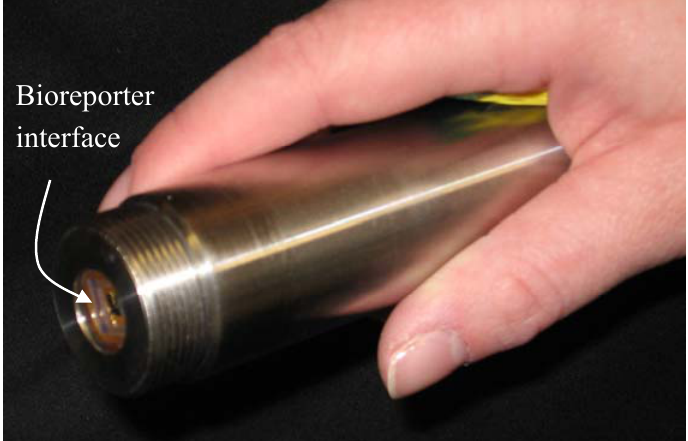
Figure 2. Example of a CMOS microluminometer transducer in a hand-held biosensor format. Bioreporter cells engineered to emit bioluminescent light signals are